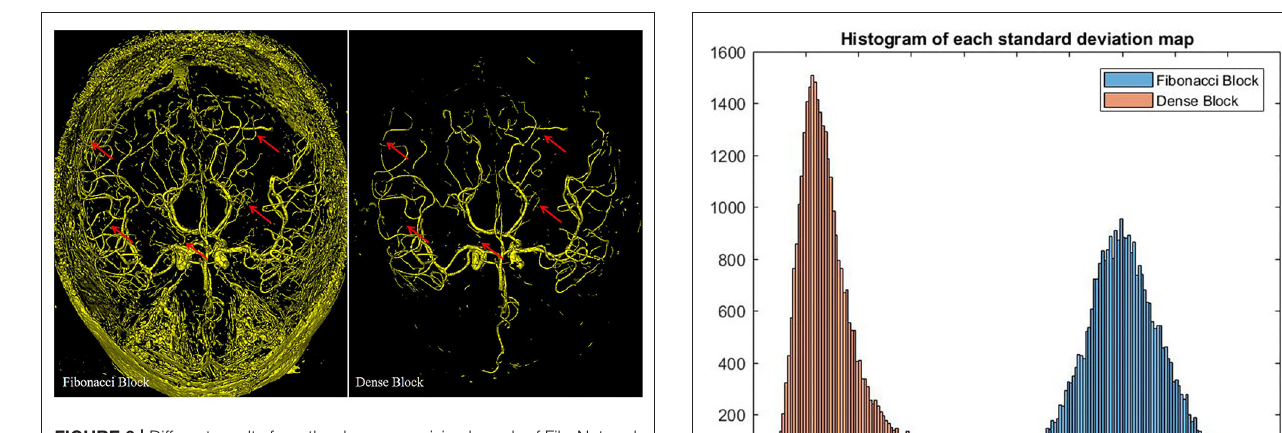
FIGURE 6 | Different results from the deep supervision branch of FiboNet and DenseVoxNet, illustrating the different detection performance of Fibonacci block and the dense block. Red arrows indicate regions where FiboNet could extract more complete vasculature than DenseVoxNet.